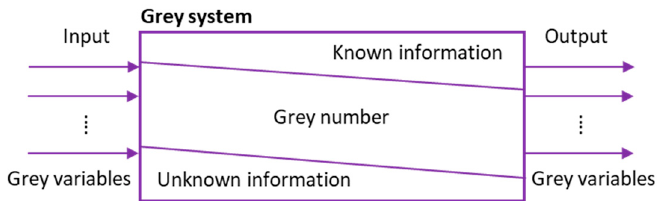
Figure 1. The concept of grey system theory. A grey number is denoted as ⨂𝑥 = (cid:3427)𝑥, 𝑥(cid:3431), where 𝑥 is the lower bound, and 𝑥 is the upper bound of the membership function. The exact value of the grey number is un- known, but the interval range within which the value lies is known.